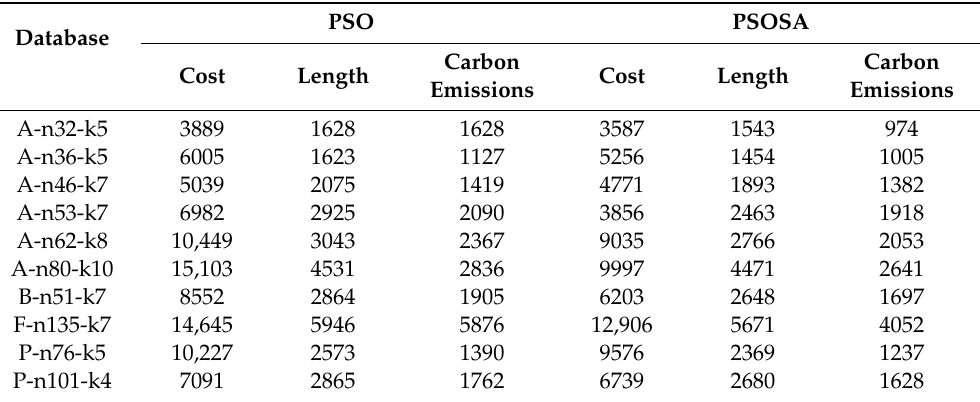
Table 5. Results of PSO and PSOSA.